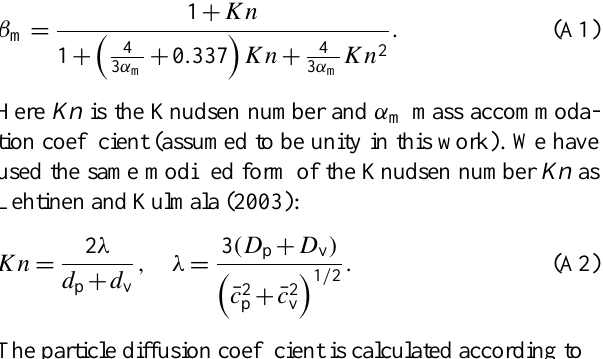
molecule mass 150 amu and liquid phase density 1.0 g cm − 3